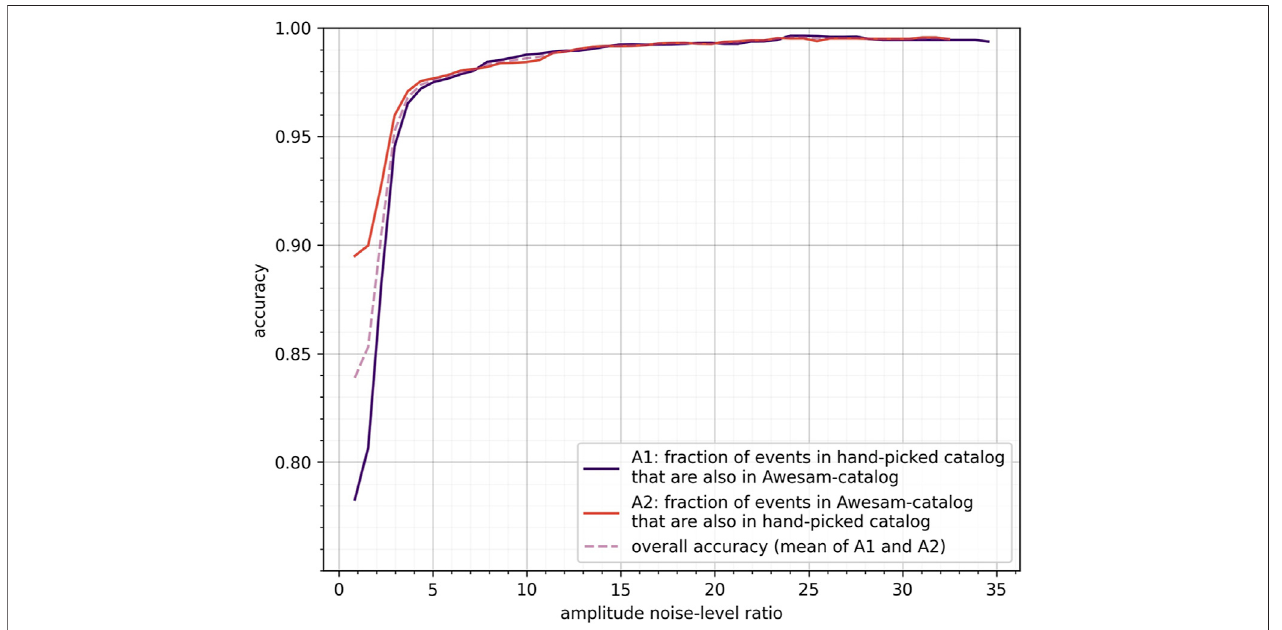
FIGURE 8 | The accuracy curves show how the accuracy depends on the signal-to-noise ratio. The more prominent the peak over the noise level, the higher the probability that it is detected.